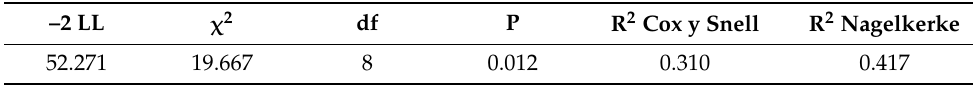
Table 5. Binary logistic regression model fit.